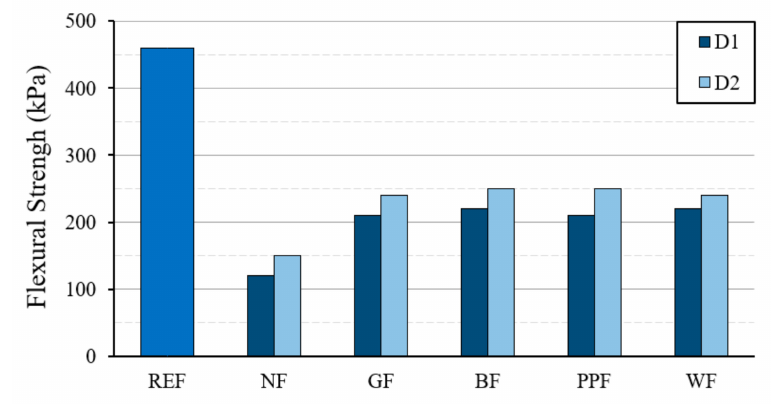
Figure 9. Results of flexural strength in 50 × 30 × 2 cm 3